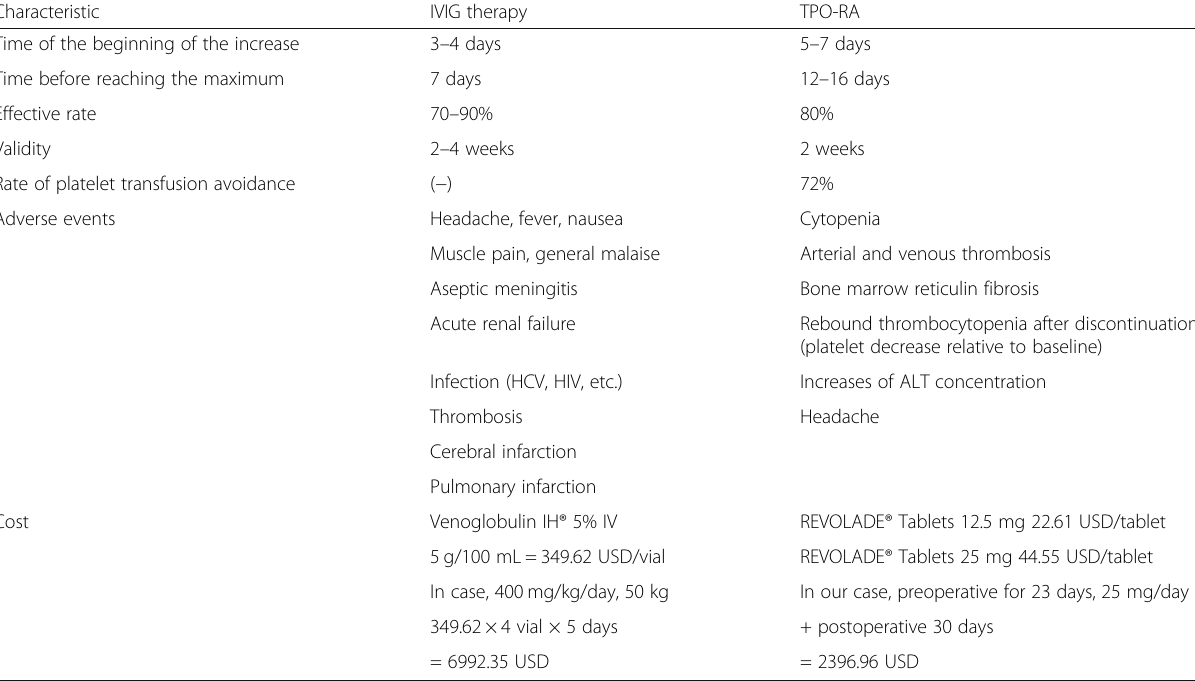
Table 2 Comparison of high-dose intravenous immunoglobulin (IVIG) therapy and thrombopoietin receptor agonist (TPO-RA) Characteristic IVIG therapy